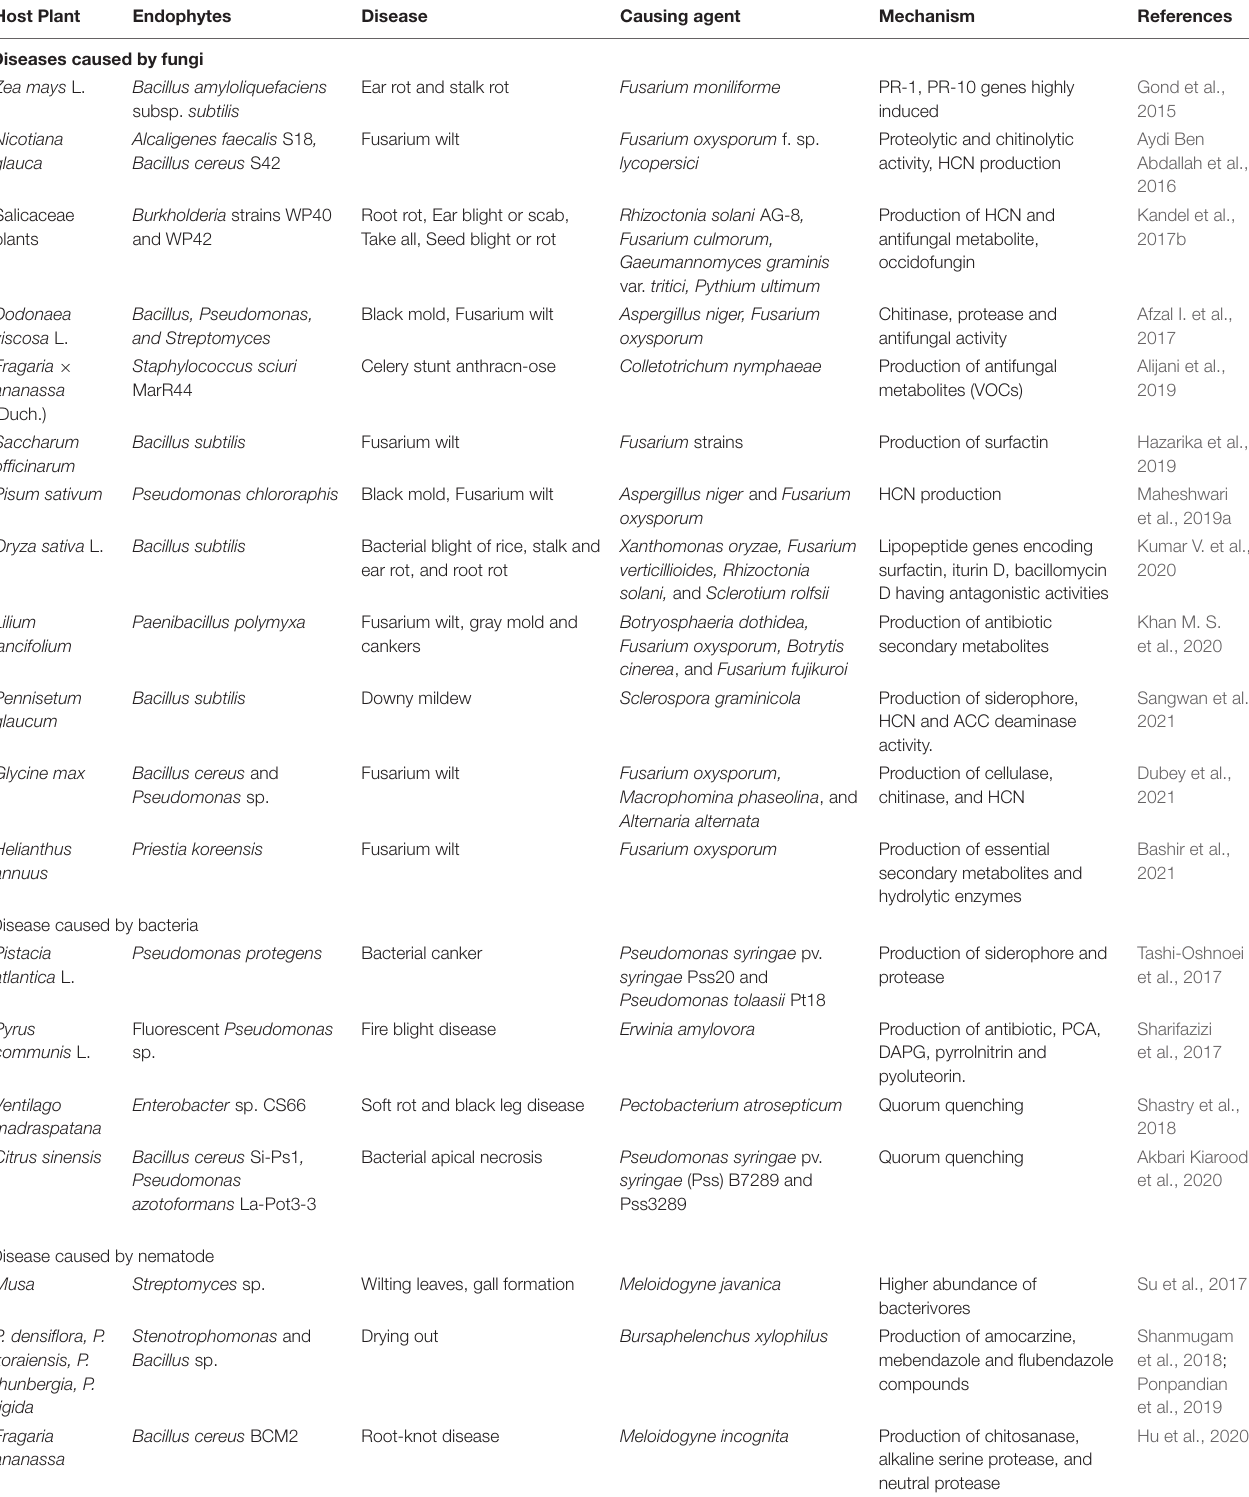
TABLE 4 | Biocontrol of phytopathogens using bacterial